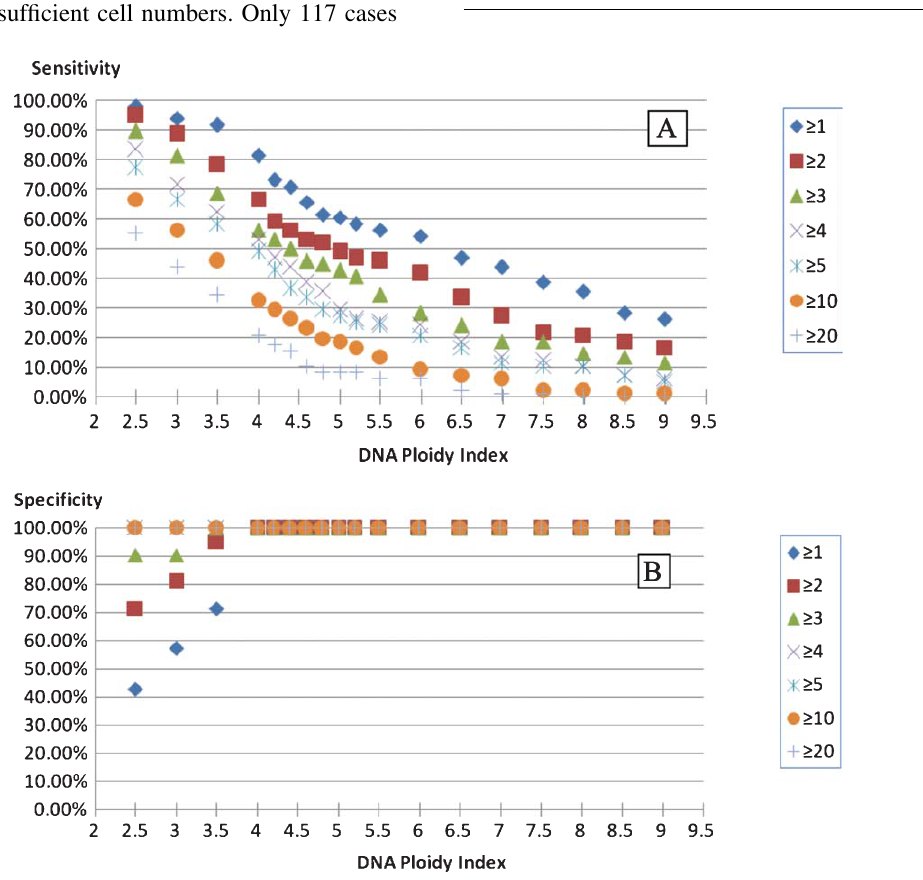
Fig. 1. Sensitivity (A) and specificity (B) of diagnosis of effusion by DNA ploidy expressed as cut off values of DNA ploidy index (ranging from 2.5c to 9c) and minimum number of cells (ranging from 1 to 20